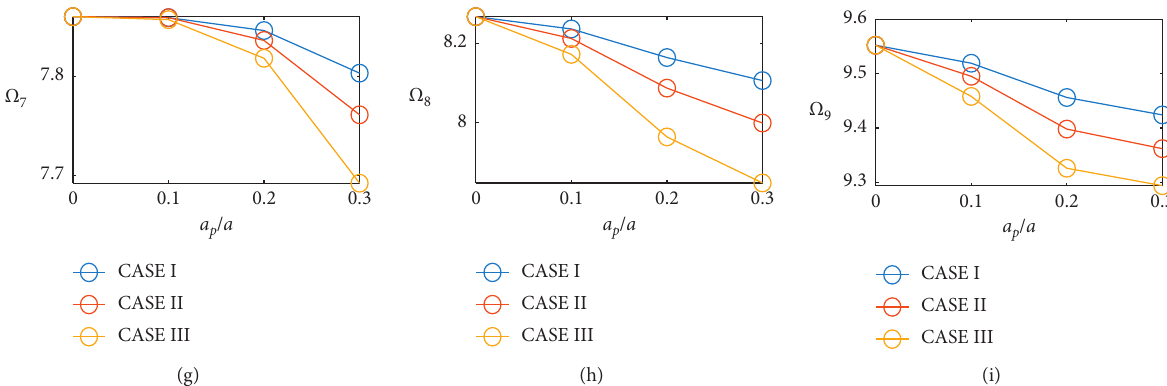
Figure 9: Nondimensional frequencies of the angle-ply laminate ([45/ − 45]s) with SSSS boundary condition, E 1/ E 2 � 10, a � 2b, and b � 10h and for different patch sizes and